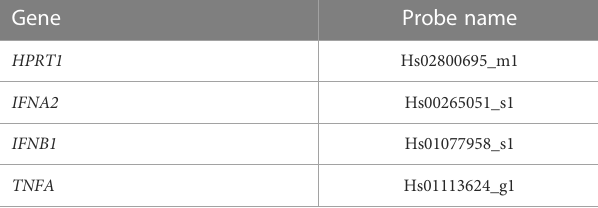
TABLE 1 Probes used for human RNA quanti fi cation with RT-qPCR.